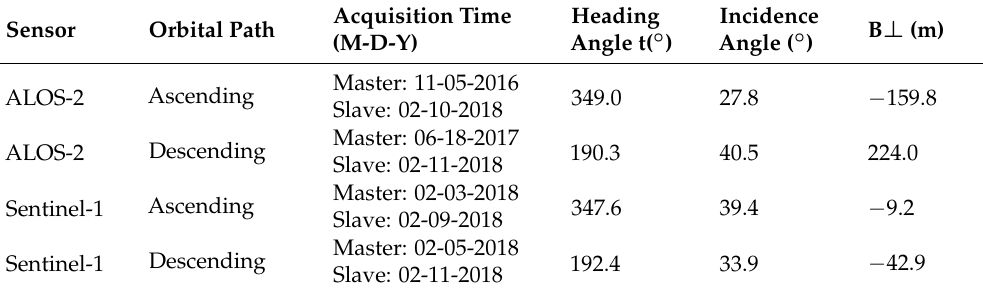
Table 1. Parameters of interferometric pairs of ALOS-2 and Sentinel-1 SAR